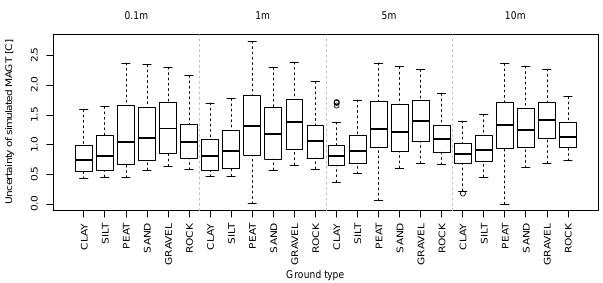
Fig. 12. Boxplots of the total output uncertainty for all topographic locations, presented for all ground types and depths. The parametric uncertainty is increased for sand, peat, gravel and